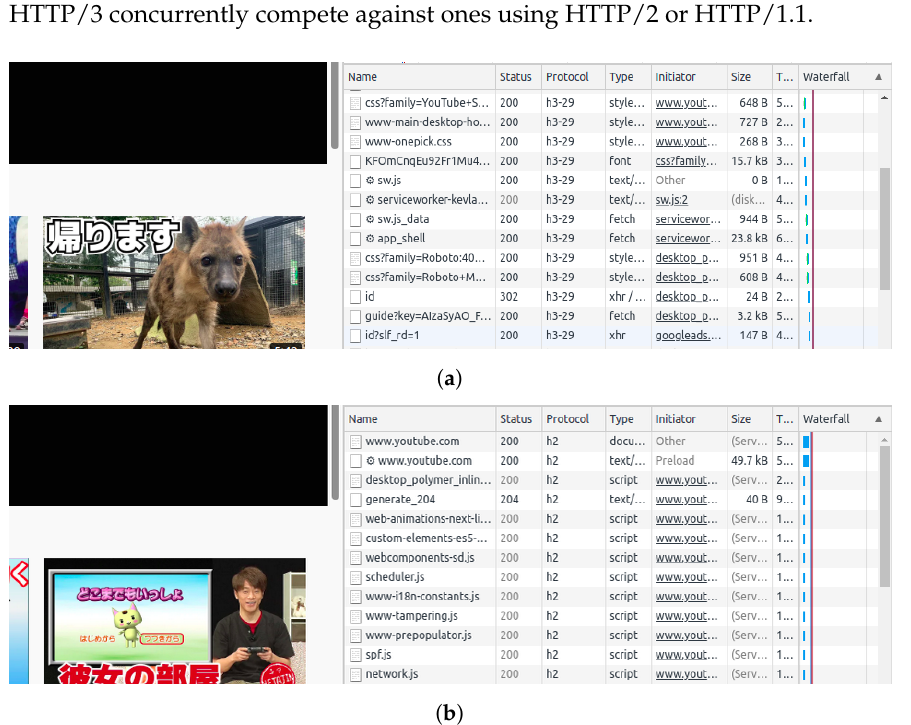
Figure 1. An example realistic case of Youtube where the HTTP/3 cannot be utilized. ( a ) A normal client that successfully sends HTTP/3 requests (h3-29); ( b ) a firewall-controlled client that fails to send HTTP/3 requests and has to use HTTP/2 (h2)